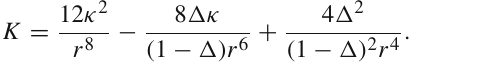
√ 8 π , the solid angle